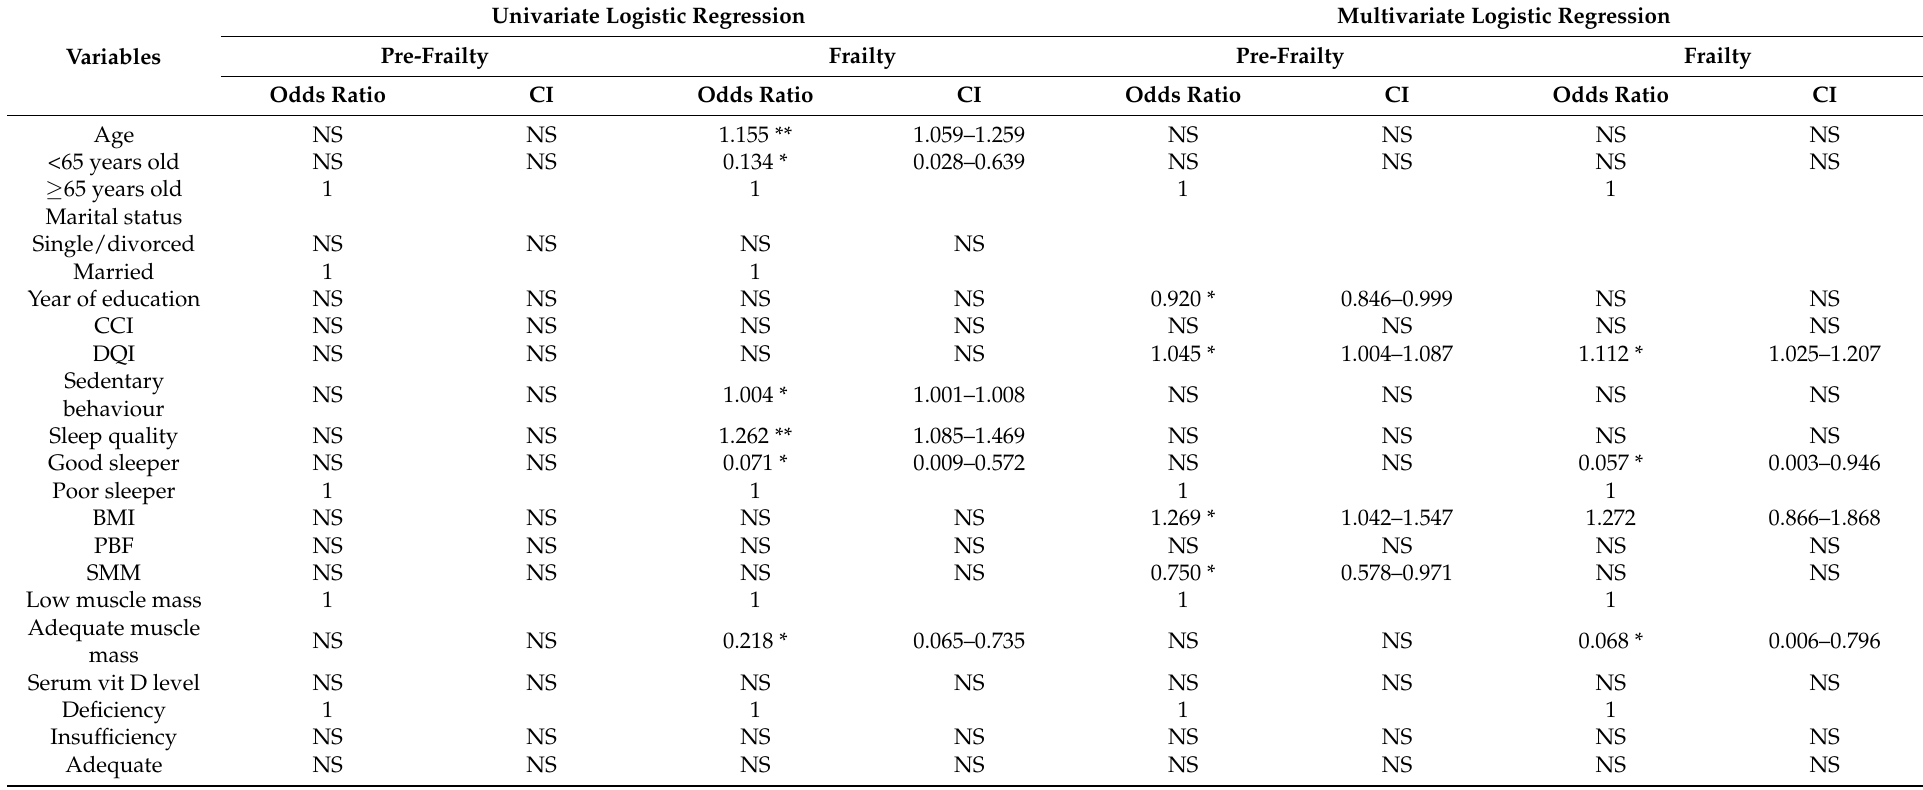
Table 3. Multinomial logistic regression between variables and